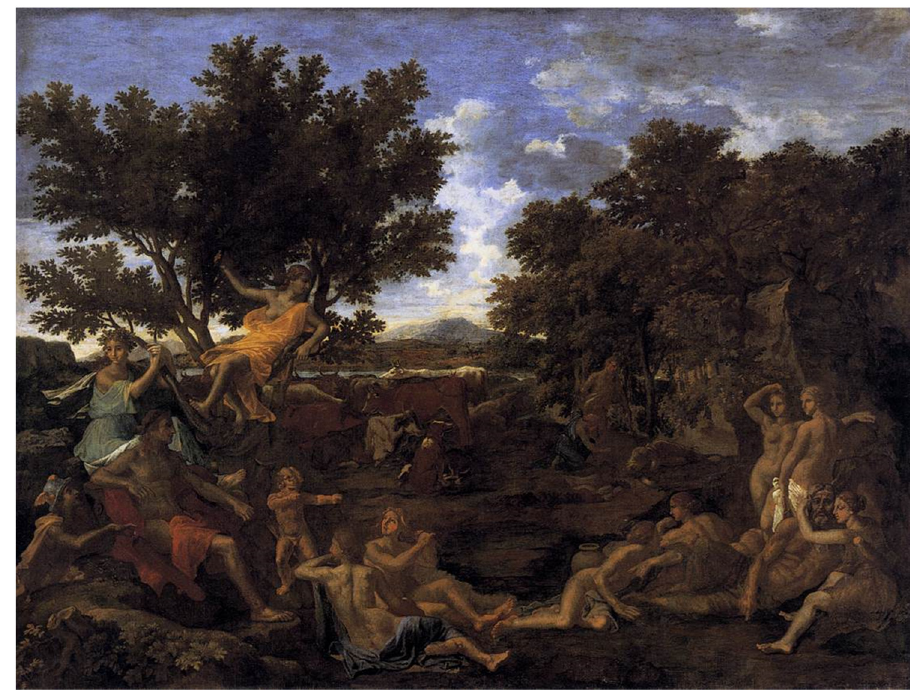
Figure 26: Poussin, Apollon amoureé de Daphné , 1664. Louvre. Public Domain.